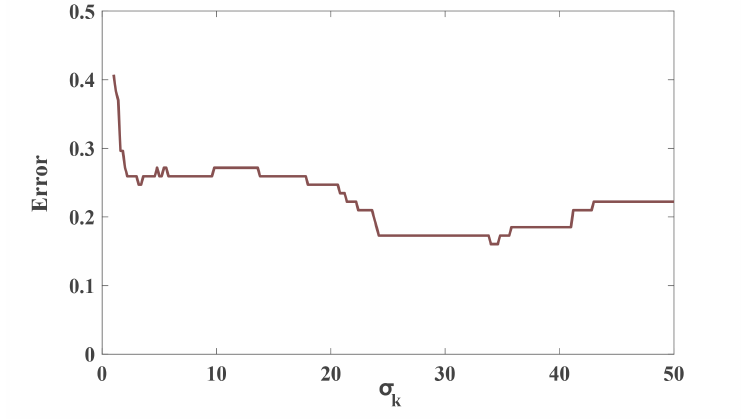
Figure 15. The relationship between the error rate in which the obscured links are wrongly selected as unobscured ones with changing σ k